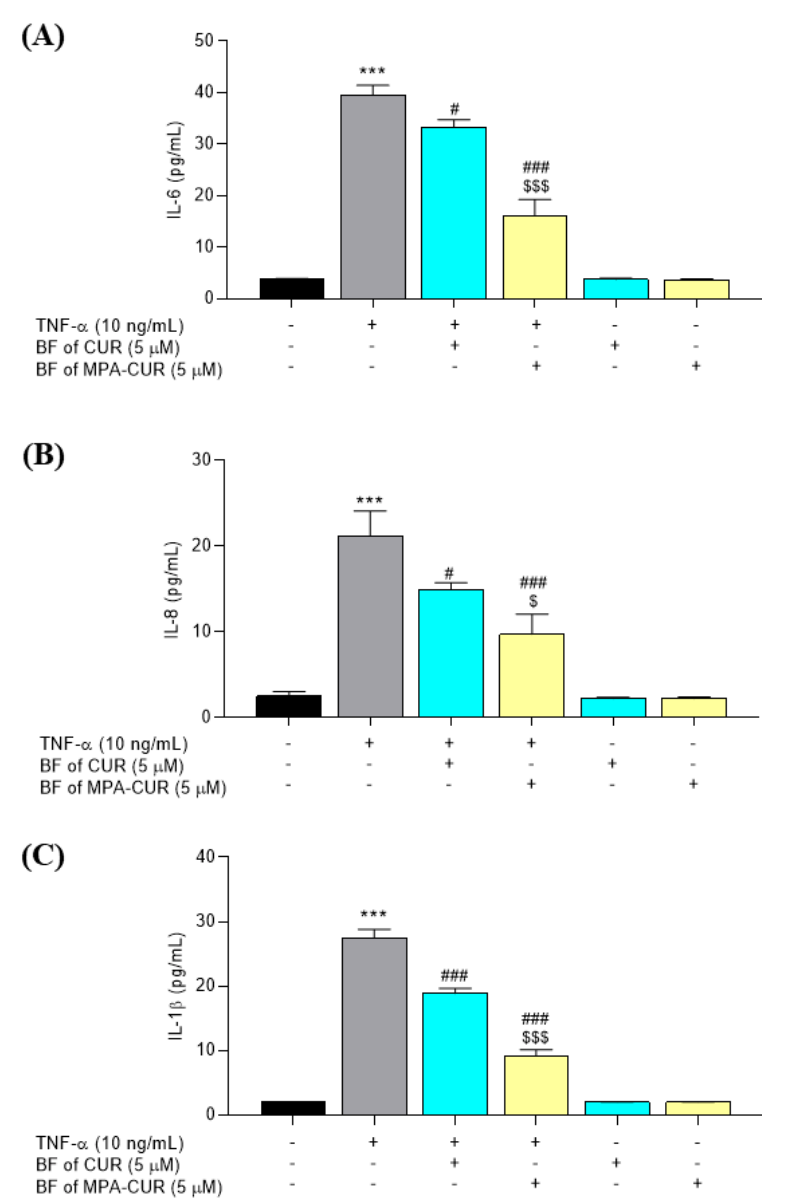
Figure 6. The effects of the BF of MPA-CUR on the expression of inflammatory cytokines, IL-6, IL-8, and IL-1 β , following treatment with TNF- α in HaCaT cells ( A – C ). Data presented are mean ± SD values of three replicates *** p < 0.001 indicates significance from the untreated control cells, # p < 0.05 and ### p < 0.001 indicates significance from the TNF- α control group and $ p < 0.05 and $$$ p < 0.001 indicates significance from the BF of CUR treated group.